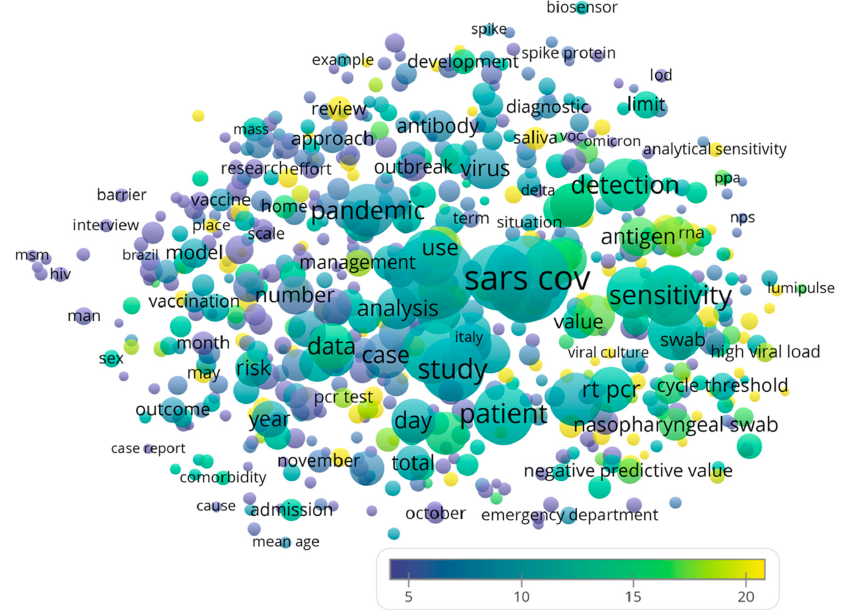
Figure 1. Term map generated using VOSviewer showing recurring terms in the titles and abstracts of the literature concerning the COVID-19 rapid antigen test. Circle size indicates publication count. Circle color indicates citations per publication (CPP). Distance between circles indicates how frequently the two terms co-occurred within the analyzed